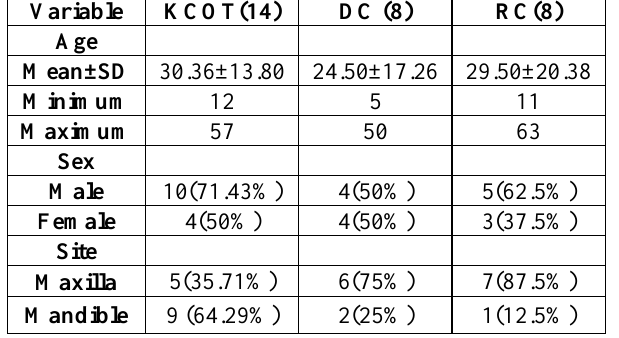
Table 1: Age, Sex, and Site Distribution for Cases with KCOT, DC and RC of the Jaw